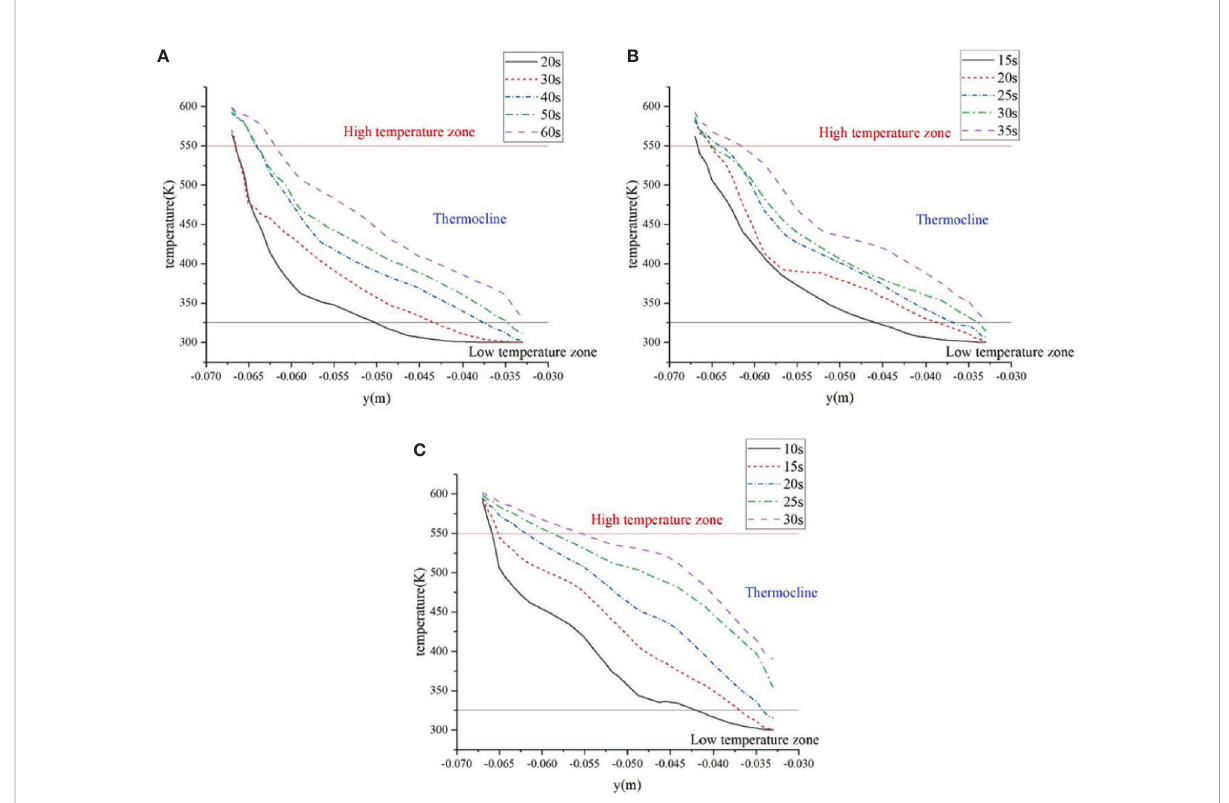
FIGURE 11 The temperature distribution curve of the central axis of the sampling chamber, (A) 0.044m/s, (B) 0.1m/s, (C)